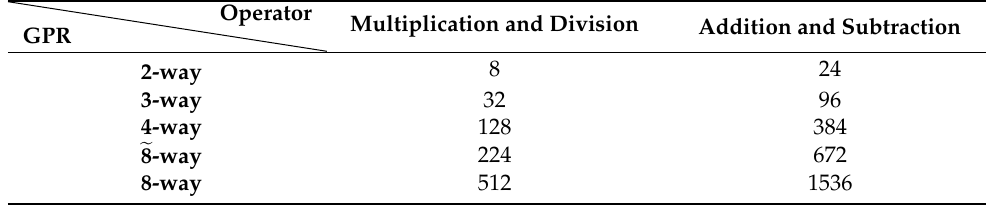
Table 2. Complexity of detection for each GPR